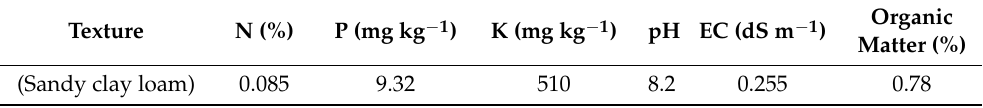
Table 3. Soil analysis results before beginning the experiment (depth 0–30